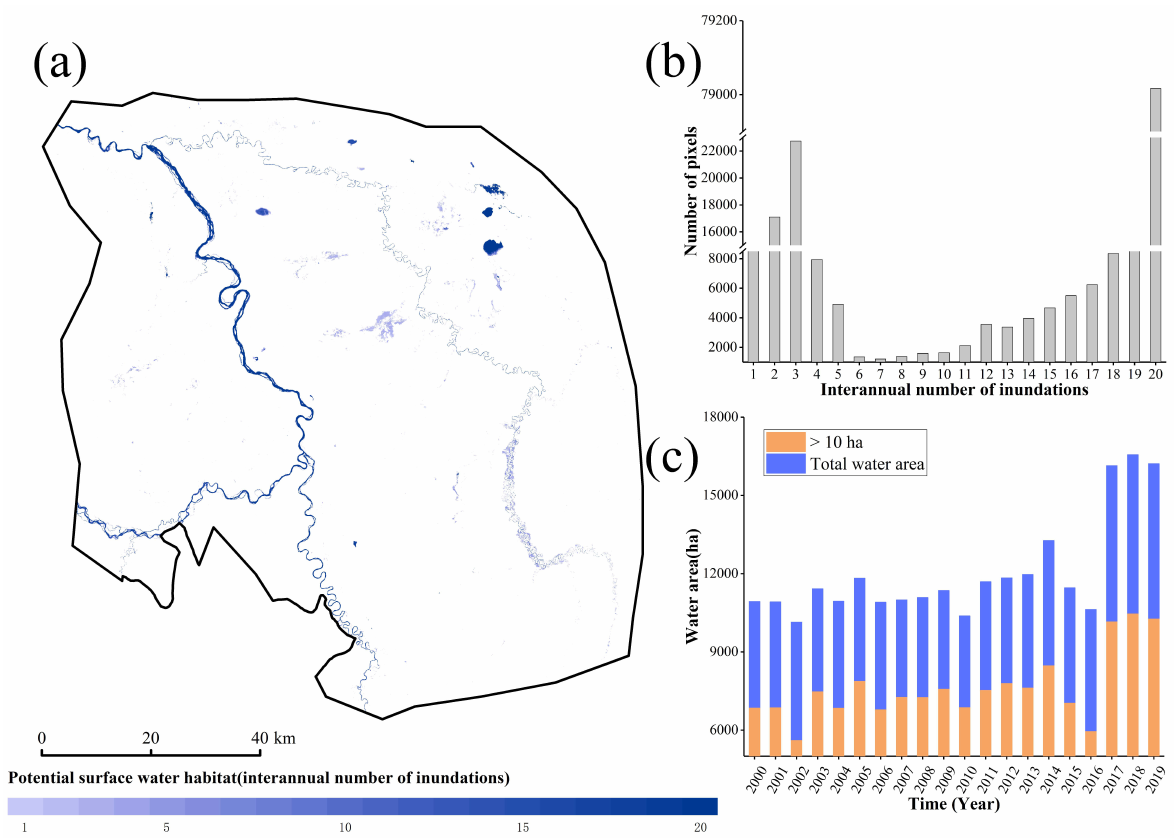
Figure 3. Distribution of surface water in the Zoig ê area. ( a ) Spatial pattern of potential surface water habitats, ( b ) Interannual pixel count for surface water, ( c ) Area statistics for surface